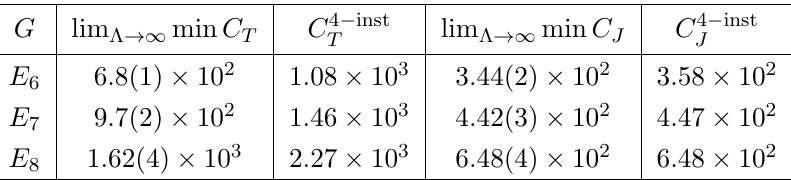
Table 7. The extrapolated lower bounds on C T and C J for interacting theories with (cid:13)avor groups G = E 6 ; E 7 ; E 8 at in(cid:12)nite derivative order, and compared to the four-instanton values in the rank-one Seiberg exceptional theories.